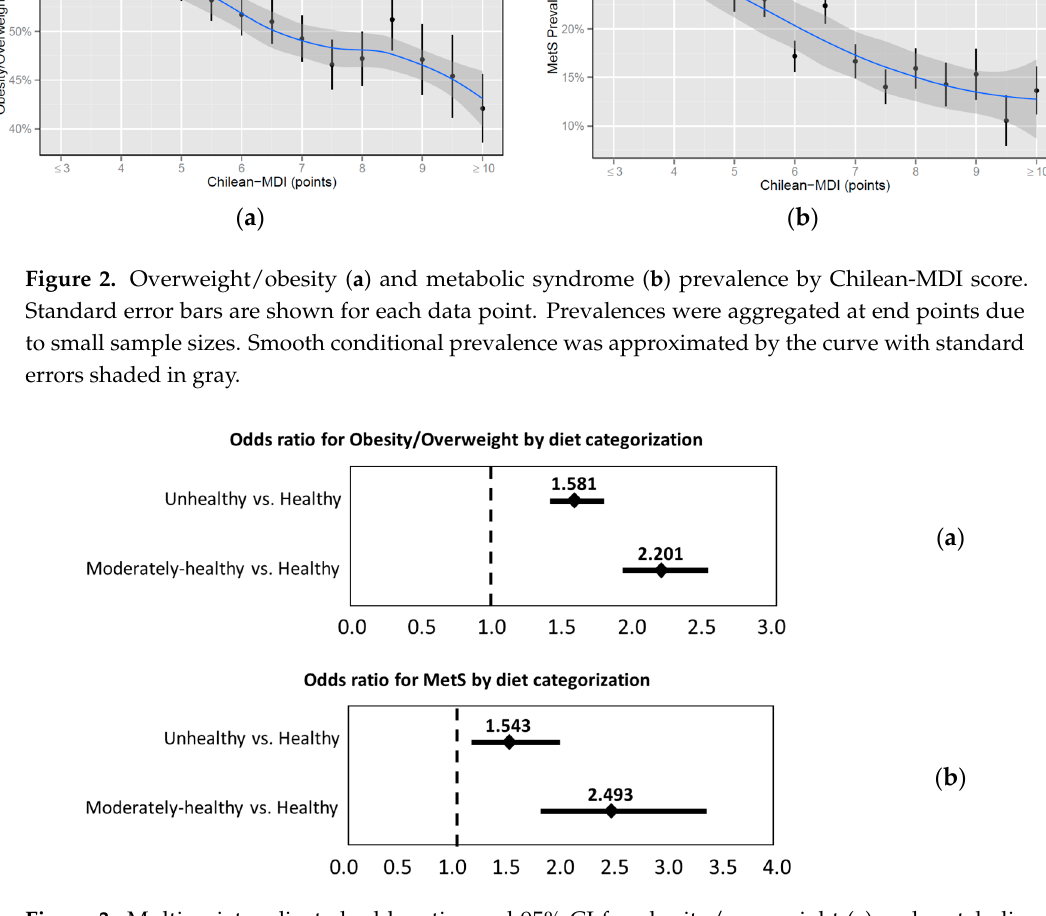
Figure 3. Multivariate adjusted odds ratios and 95% CI for obesity/overweight ( a ) and metabolic syndrome ( b ) by Chilean-MDI diet category. Odds ratios were adjusted by sex, age, years of school completed, smoking status, and physical activity.